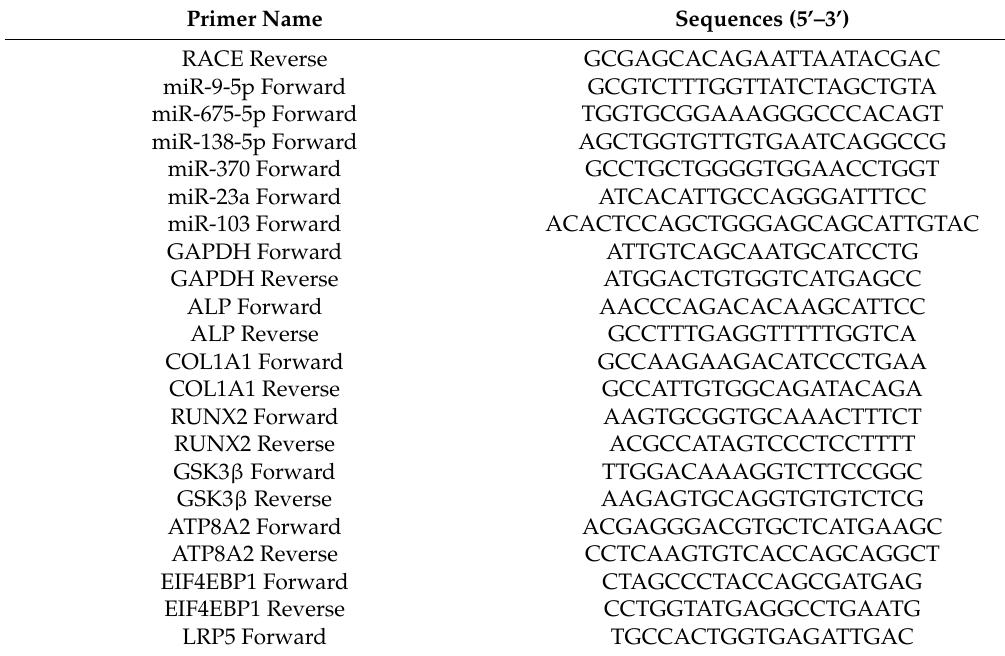
Table 1. Sequences of all